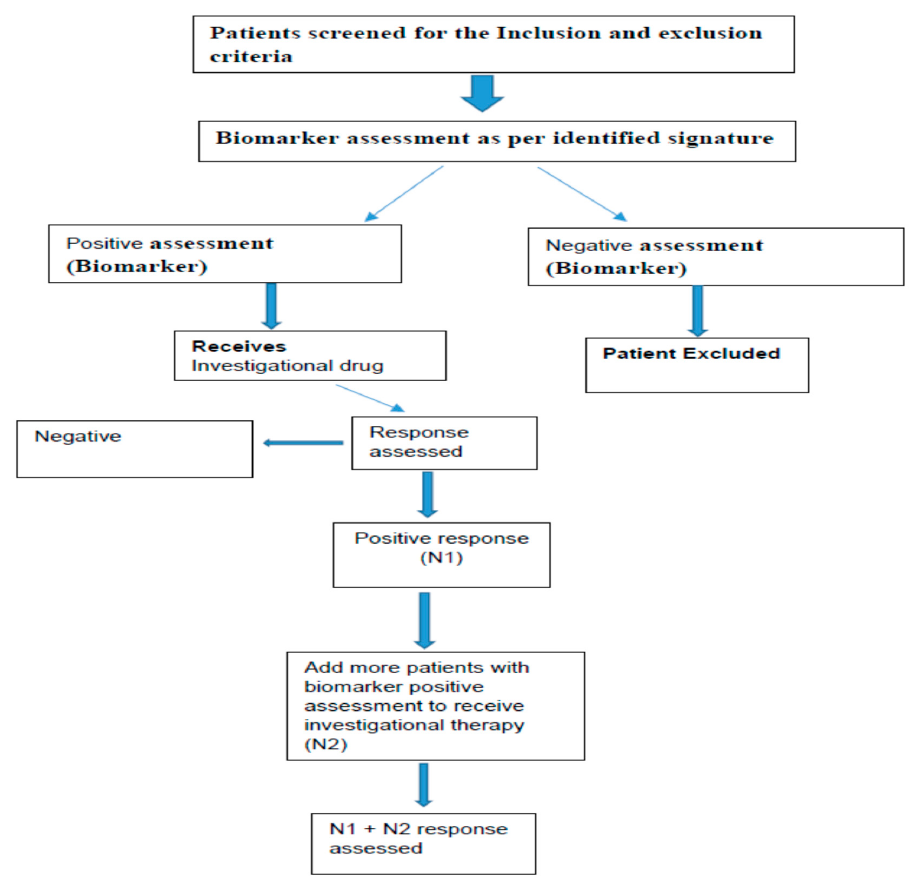
Figure 6. Open label with two-step biomarker enriched design approach.